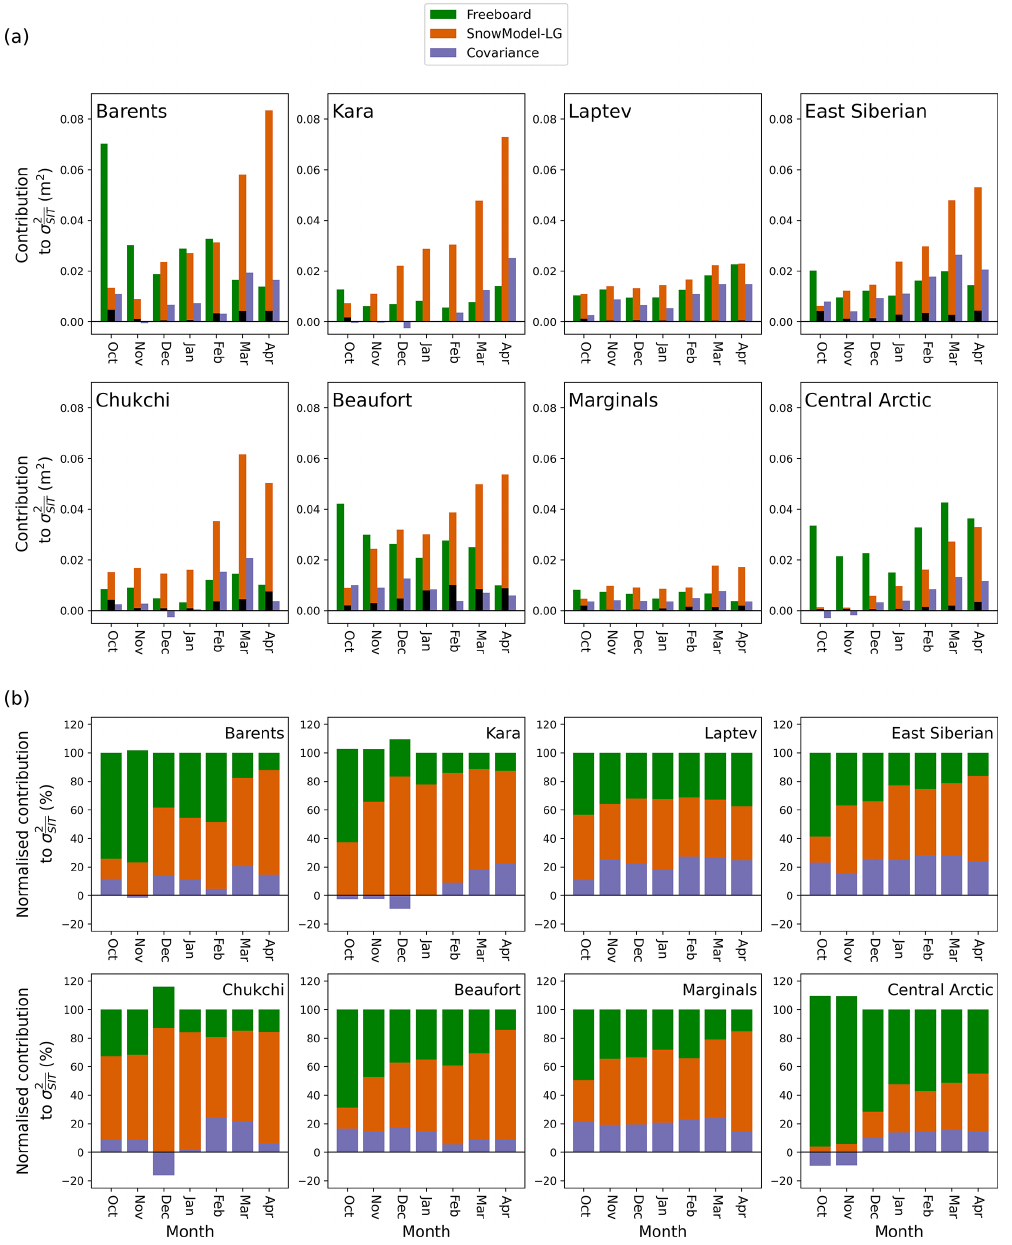
Figure 8. Constituent parts of σ 2 of different regions. Bars represent the variance ( σ 2 ) of RF and Snow and the covariance between the SIT two. Panel (a) illustrates the absolute variance contributions, and panel (b) illustrates the relative contributions. The variance of Snow in mW99 is indicated in panel (a) by a superimposed black bar. Snow contributes significantly more variability in the late winter than radar freeboard in most of the marginal